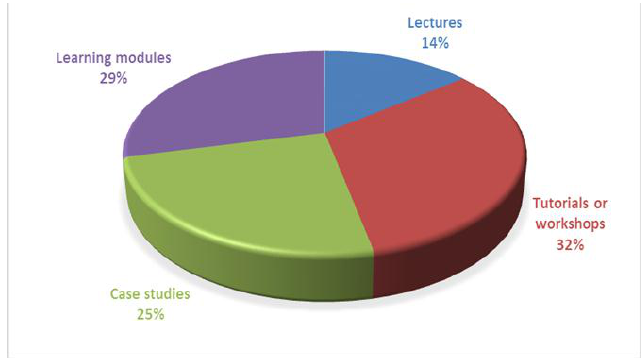
Figure 2 . The desired method of education in radiology